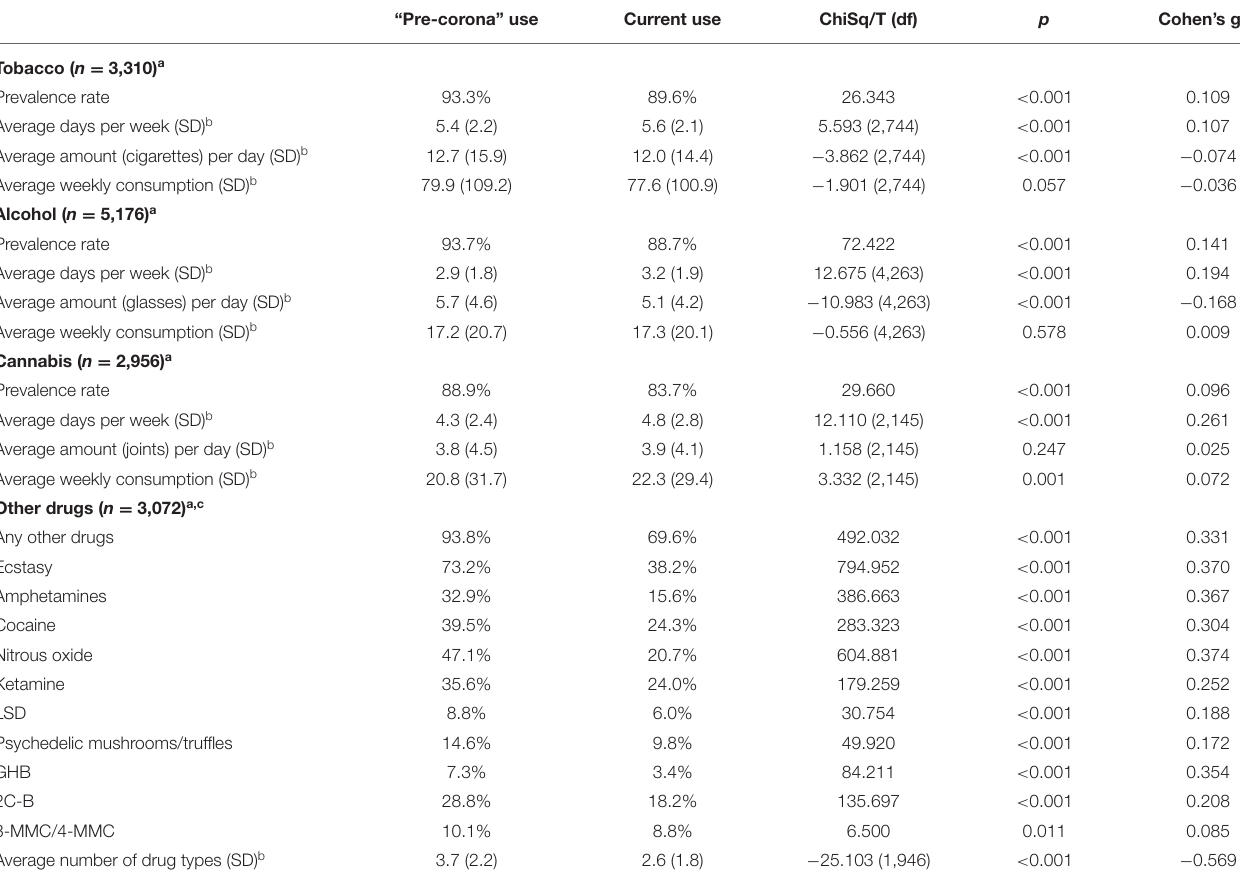
TABLE 2 | “Pre-corona” and current use of tobacco, alcohol, cannabis, and other drugs (paired tests). “Pre-corona”